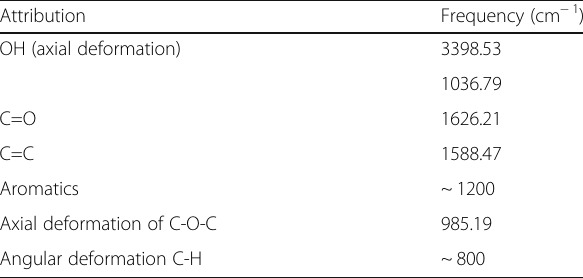
Table 2 Attributions of the main bands of the naringin